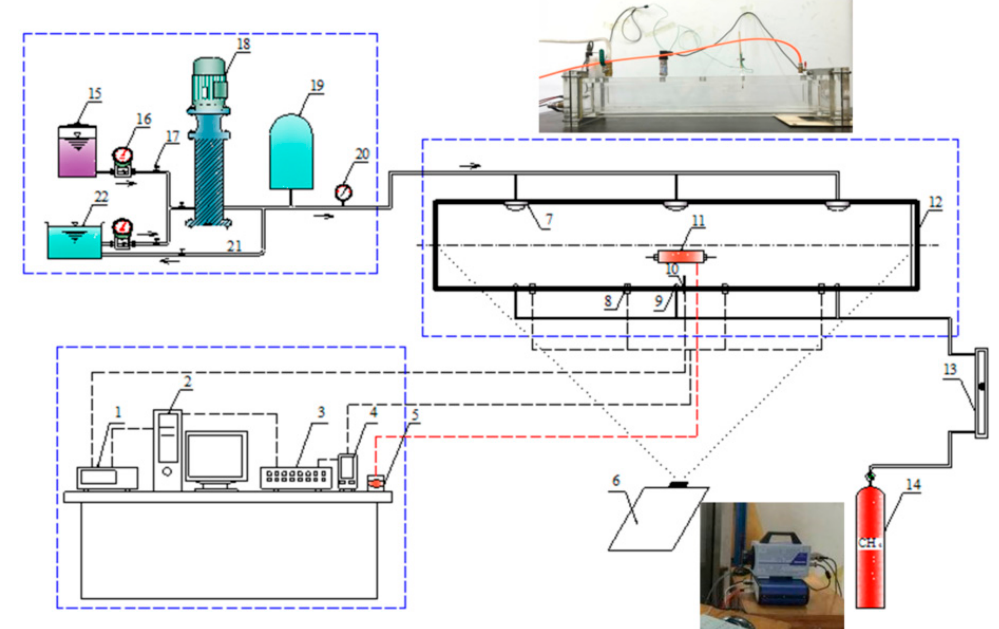
Figure 2. Experimental system for suppressing gas combustion using water mist: 1 data acquisition unit, 2 computer, 3 signal converter, 4 signal acquisition, 5 ignition device, 6 high speed camera, 7 nozzle, 8 pressure sensor, 9 gas release mouth, 10 temperature sensor, 11 igniter, 12 combustor, 13 float flow meter, 14 gas bottle, 15 additive, 16 flow meter, 17 valve, 18 high pressure pump, 19 energy accumulator, 20 pressure gage, 21 wet return, 22 water tank.